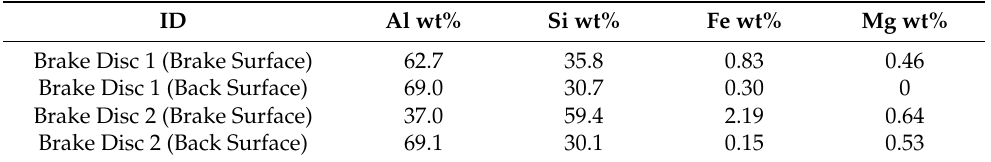
Table 3. PMI test results. Note that the Innov-X Delta DP2000CC analyses for elements with atomic number greater than 12 therefore the carbon and nitrogen content could not be